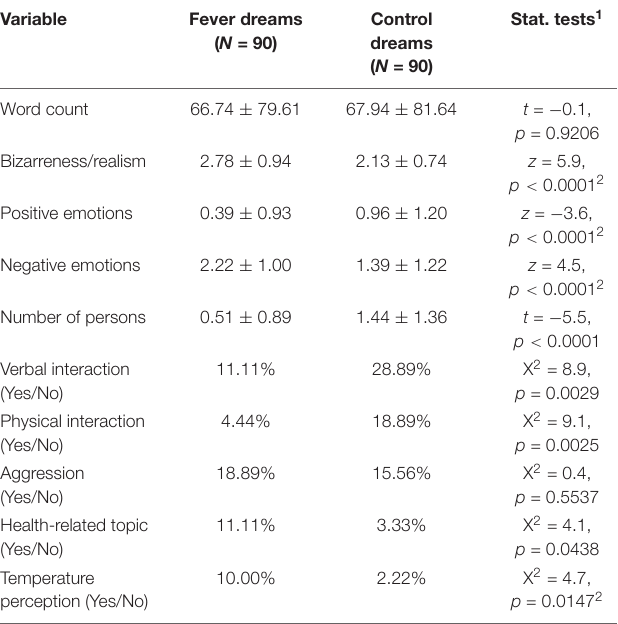
TABLE 3 | Fever dreams and control